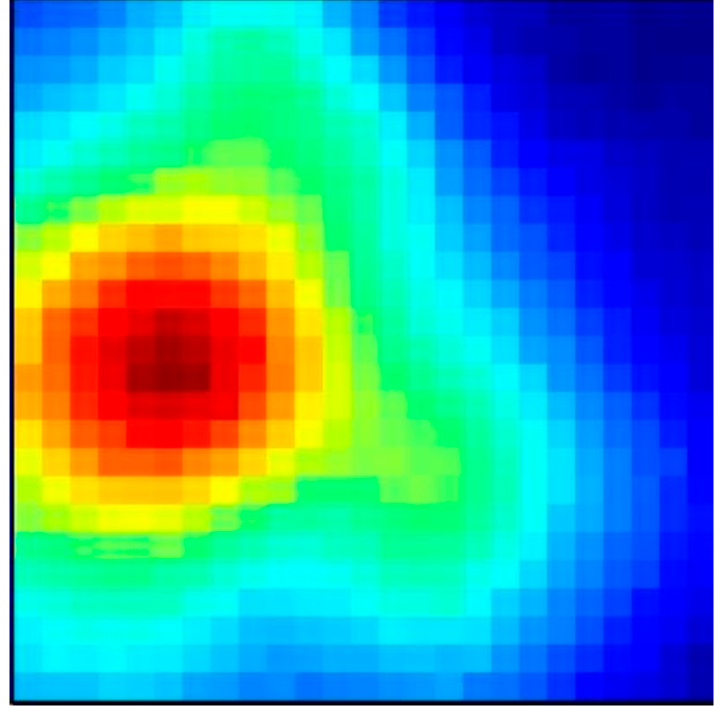
Figure 10. An indoor acoustic map with 25 × 25 pixels.